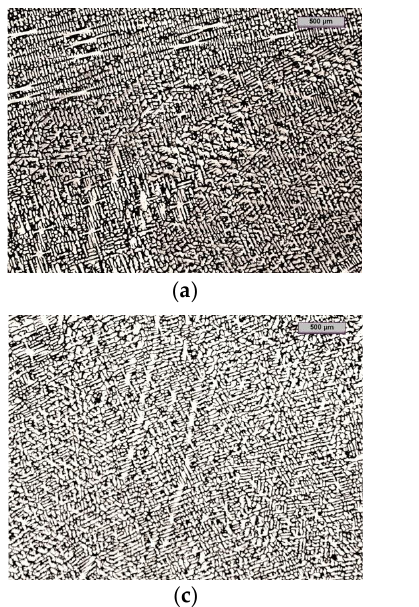
Figure 3. Chromium cast iron microstructure inoculated with (wt.%): ( a ) 0.0 Fe – Ti; ( b ) 0.17 Fe – Ti; ( c ) 0.33 Fe – Ti; ( d ) 0.66 Fe – Ti (magnification – 25x).